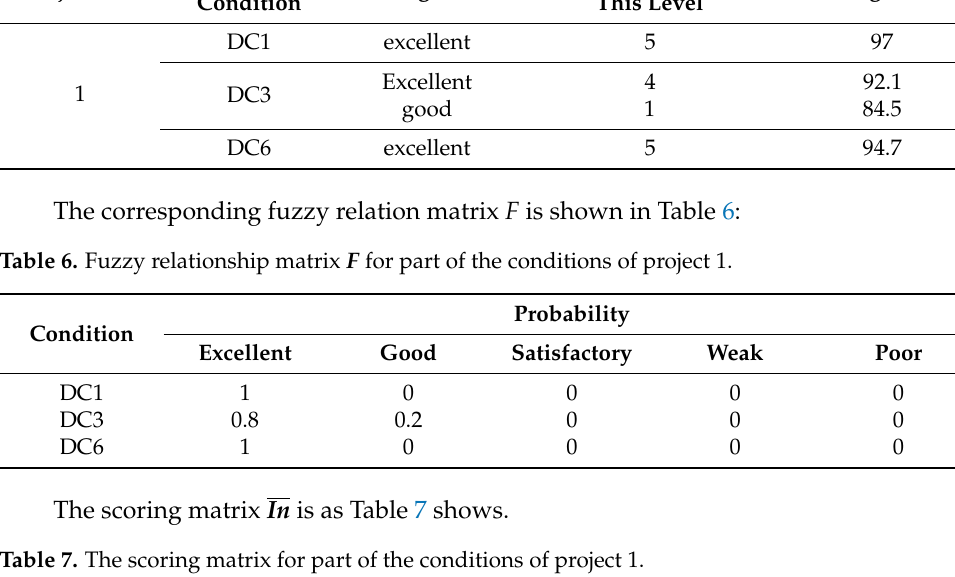
Table 5. Statistics of planners’ ratings for part of the conditions of project 1. Project No.